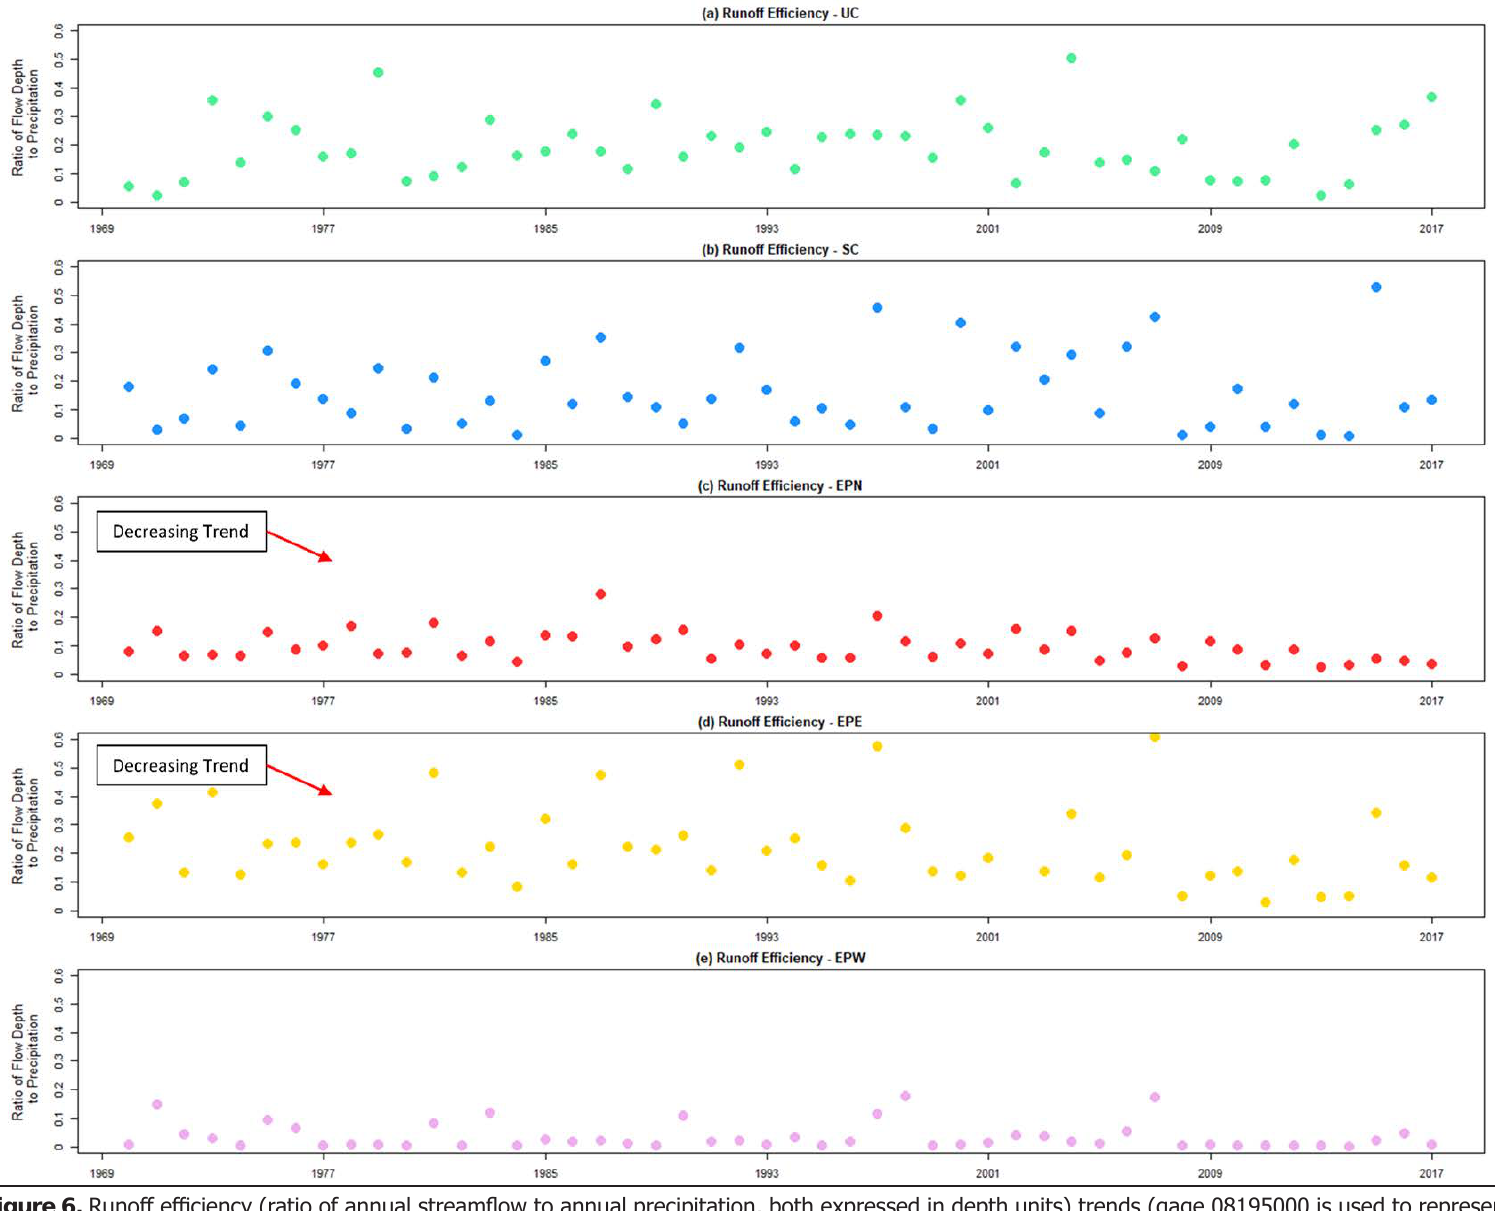
Figure 6. Runoff efficiency (ratio of annual streamflow to annual precipitation, both expressed in depth units) trends (gage 08195000 is used to represent the EPE